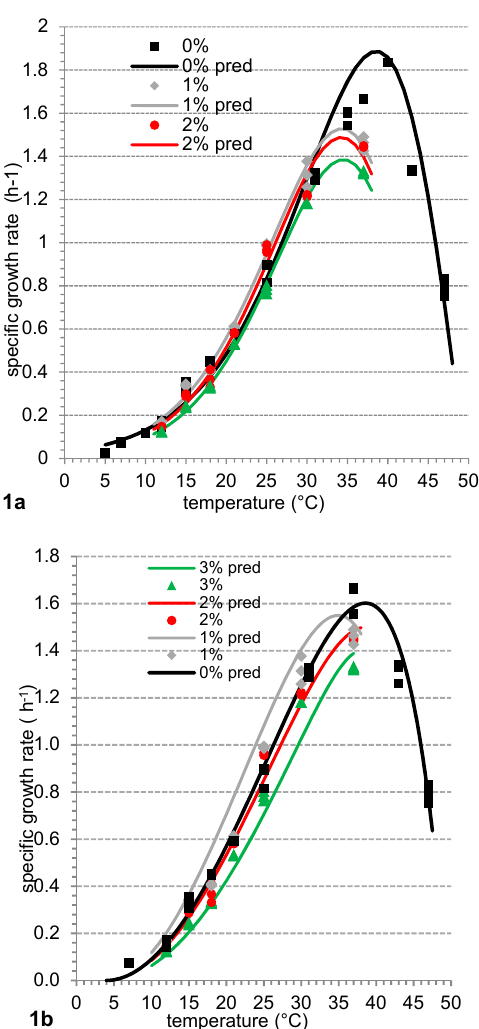
Figure 1. Plots of the specific growth rates ( μ ) versus temperature ( T ) for Fresco culture in milk according to (a) Gibson’s model and (b) CTMI model (solid line). Symbols indicate the μ calculated from the growth curves at each incubation temperature. The continuous lines indicate the fitted μ versus T function according to each model for 0% ( ■ ), 1% ( ♦ ), 2% ( ● ) and 3% ( ▲ ) of salt.